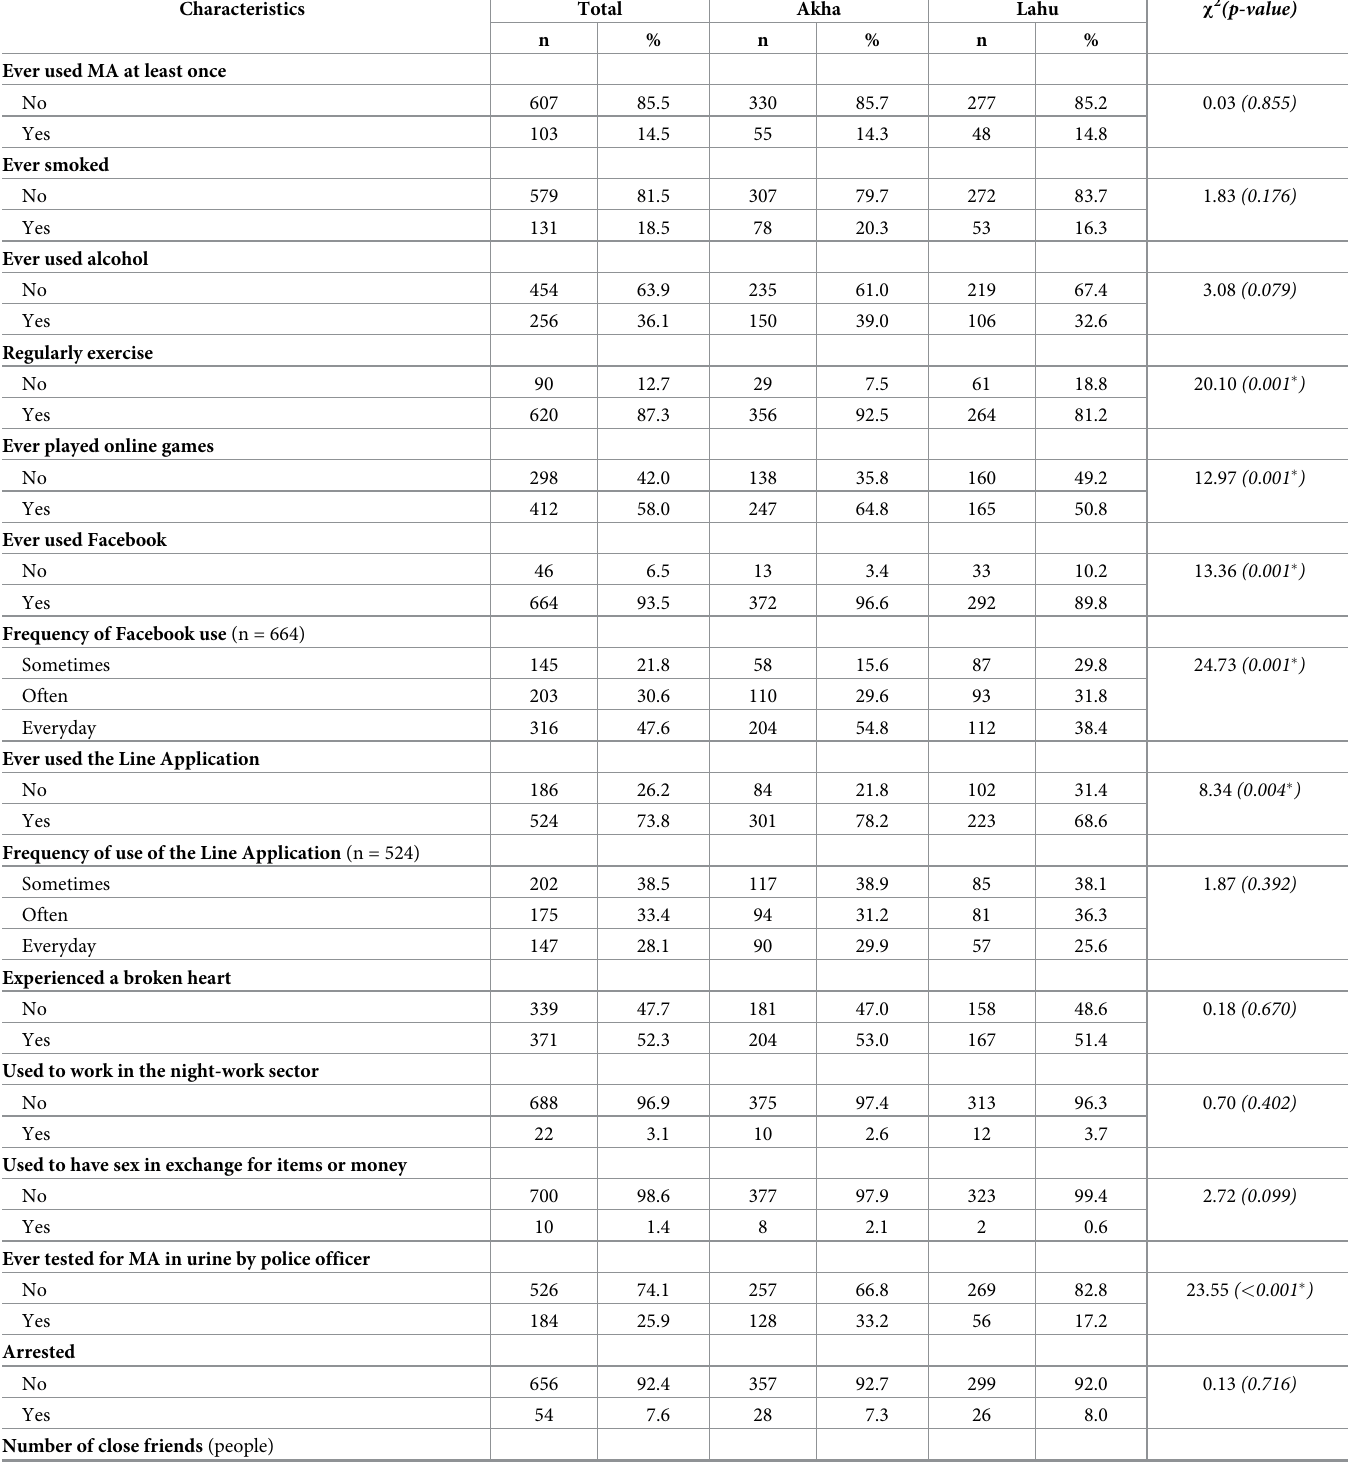
Table 5. Participants’ behaviors and personality.